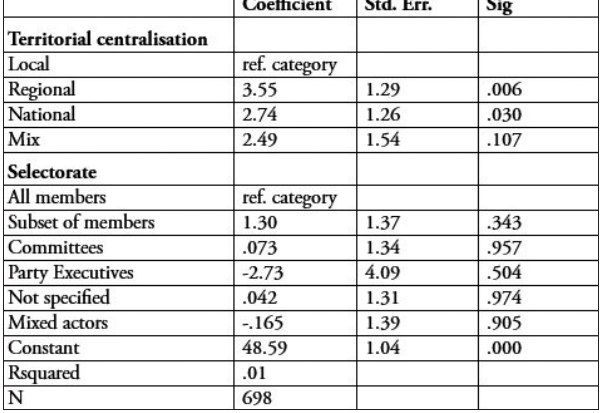
Table 4: The influence of nomination procedures and the size of the selectorate on the age of parliamentarians, at the start of a term (2009 sub-sample)